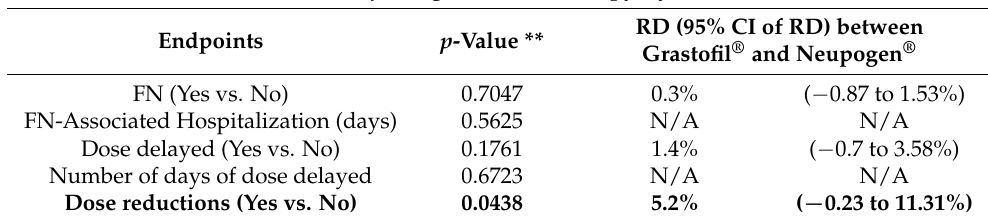
Table 6. Combined Cycle Breast Cancer Risk